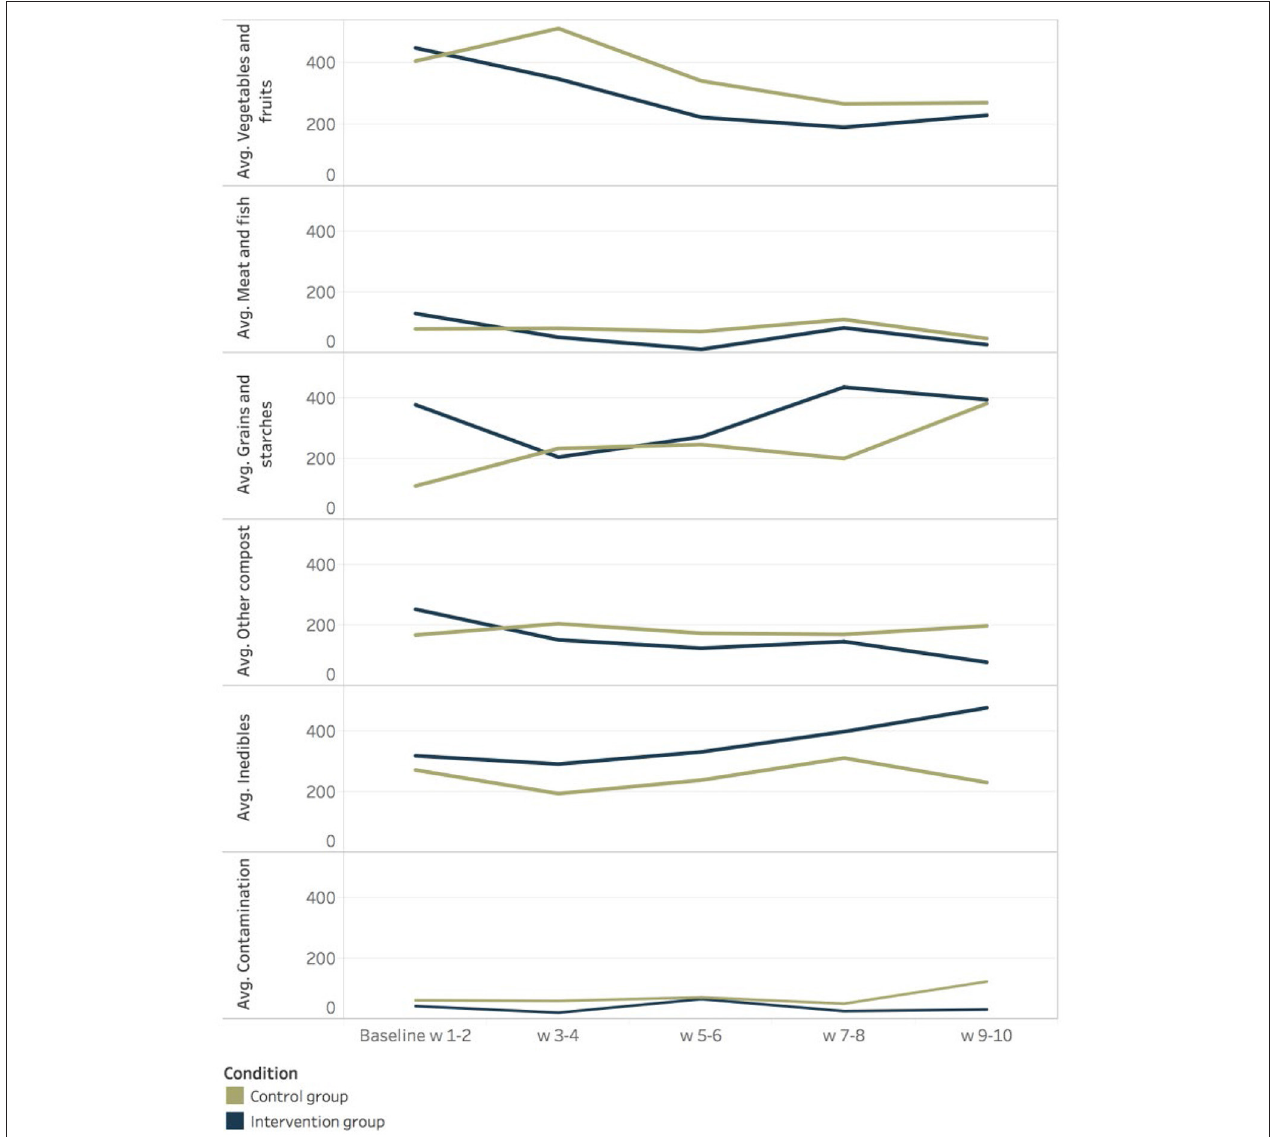
FIGURE 8 | Average amounts (in grams) of all six waste types generated by the control vs. intervention group presented per 2 weeks. Waste types are (from top to bottom): (1) edible or once edible vegetables and fruits, (2) meat and fish, (3) grains and starches, (4) in-edibles such as peels, tea bags, bones, and egg shells, (5) other compost or non-food organics such as paper towels, and (6) contamination with glass or plastics. w,